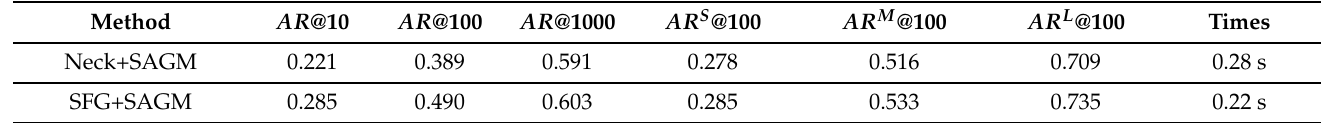
Table 6. Comparison results of the SFG and the Neck on the LEVIR dataset.